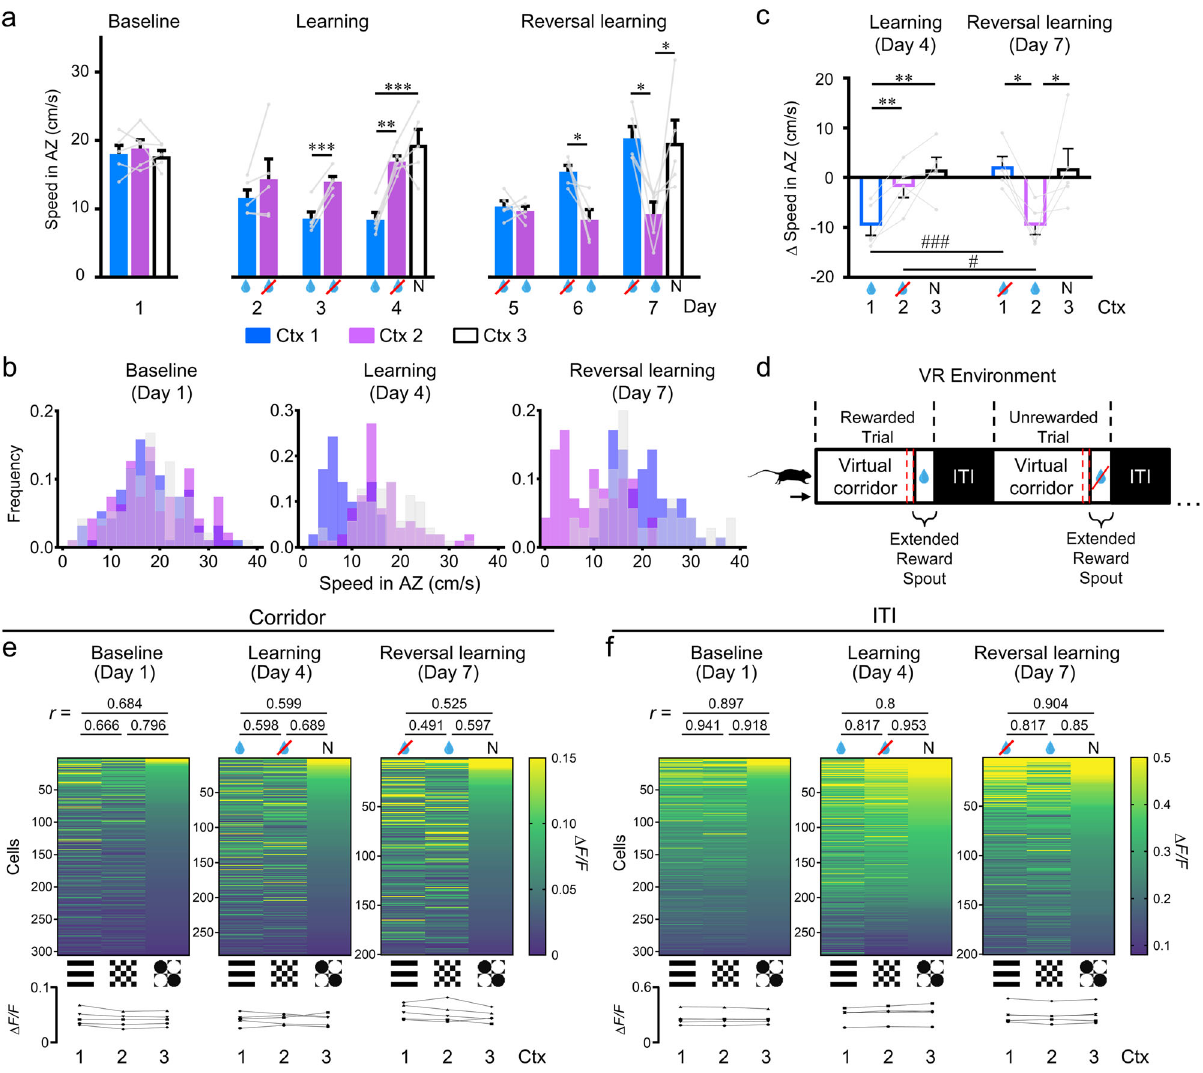
Fig. 2 Mice exhibit context discrimination by differentiated running speed and distinct patterns of neuronal activity in dysgranular RSC neurons across rewarded and non-rewarded contexts. a Mean running speed in the anticipation zone across days and learning phases. Rewarded context (blue drop); Non-rewarded context (drop with red cross); Neutral context (N). b Distribution of speeds within the anticipation zone on a trial-by-trial basis across learning phases (baseline-day 1, learning-day 4, reversal learning-day 7). c Change in speed relative to baseline for learning (day 4 – day 1) and reversal learning (day 7 – day 1). d Schematic of the trial-by-trial task. The virtual corridor is presented with a speci fi c contextual pattern on the corridor walls (Ctx 1 – 3) followed by a zone where mice get rewarded or not depending on the speci fi c context, then the ITI consists of a black screen for 3 s. In both the reward period and the ITI the treadmill was stationary with external brakes applied. The anticipation zone is indicated as a red dashed area. e Mean Δ F/F for each neuron averaged along the length of the virtual corridor for each context (Ctx 1 – 3) and across learning phases (baseline-day 1, learning-day 4, reversal learning-day 7). Cells are sorted for each day according to mean Δ F/F for the neutral (N) context. Line plots at the bottom show mean Δ F/F across the entire population of cells for each context. Cross-correlations (Spearman r value) of neuronal activity between contexts are reported on top of the color maps. f Same as e but during the ITI. For all, n = 5 mice. For a and c , data are presented as mean values + SEM, and the data points are shown as gray dots with the data from the same animals linked by gray lines. For a , one-way RM ANOVA and post-hoc Holm – Sidak test were applied for the days with three contexts, and paired t -test was used for the days with two contexts, two-sided. For c , two-way RM ANOVA and post-hoc Student – Newman – Keuls tests were used. Within-day comparisons: * p < 0.05, ** p < 0.01, *** p < 0.001. Exact p- values can be found in Supplementary Dataset 1. Source data are provided as a Source Data fi